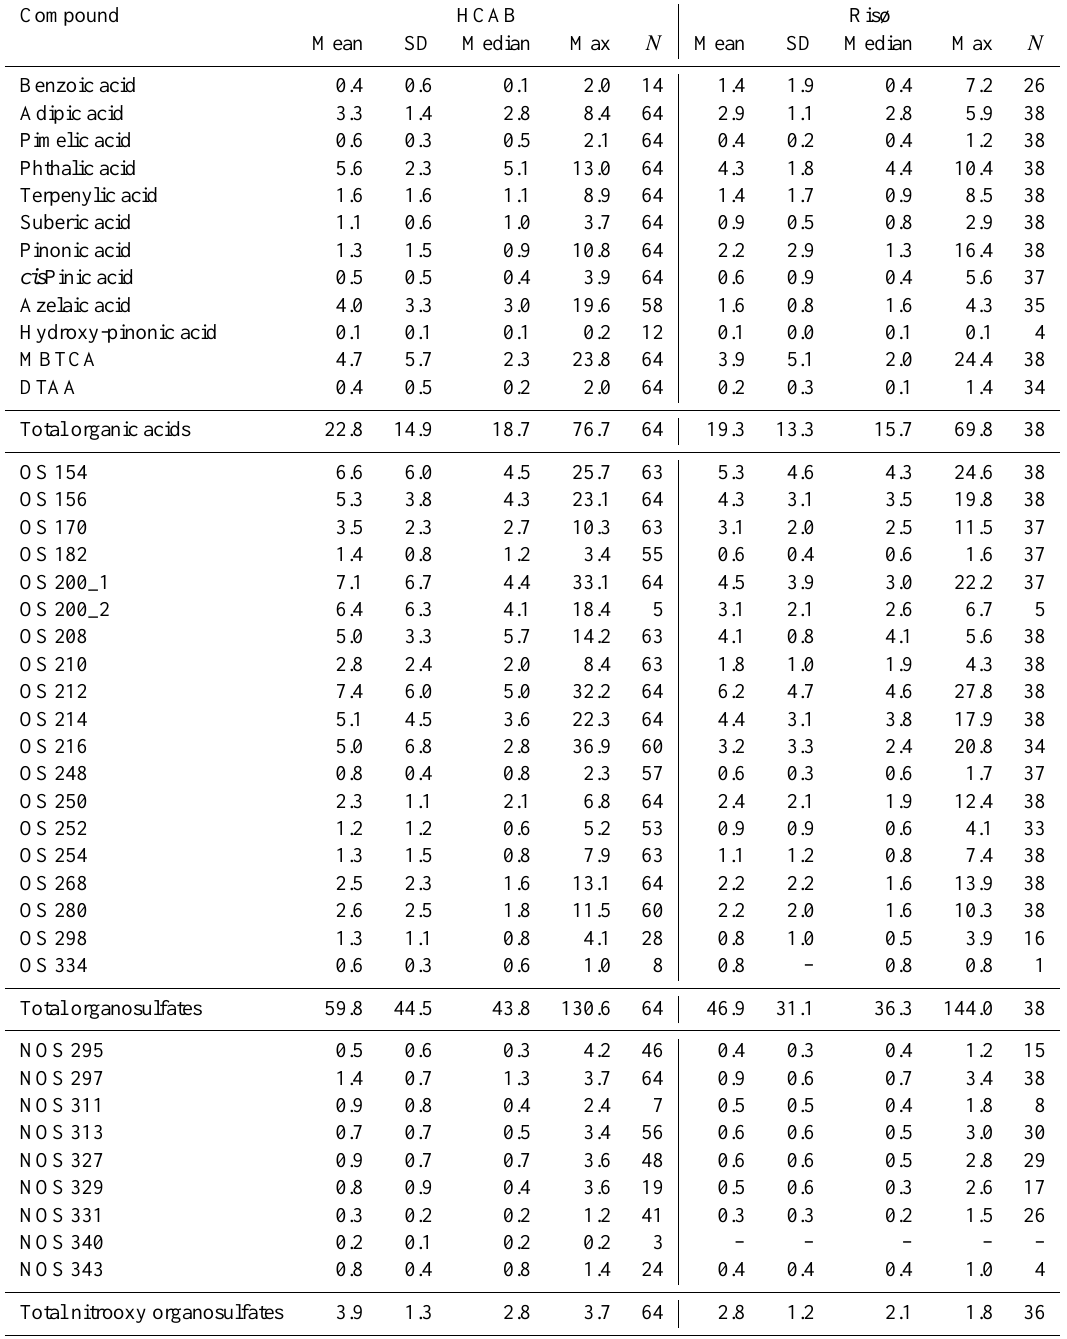
Table 4. Concentration range (ng m − 3 ) of the detected species at HCAB and Risø, reported as mean, standard deviation (SD), median, max and the number of detected samples ( N ) at each